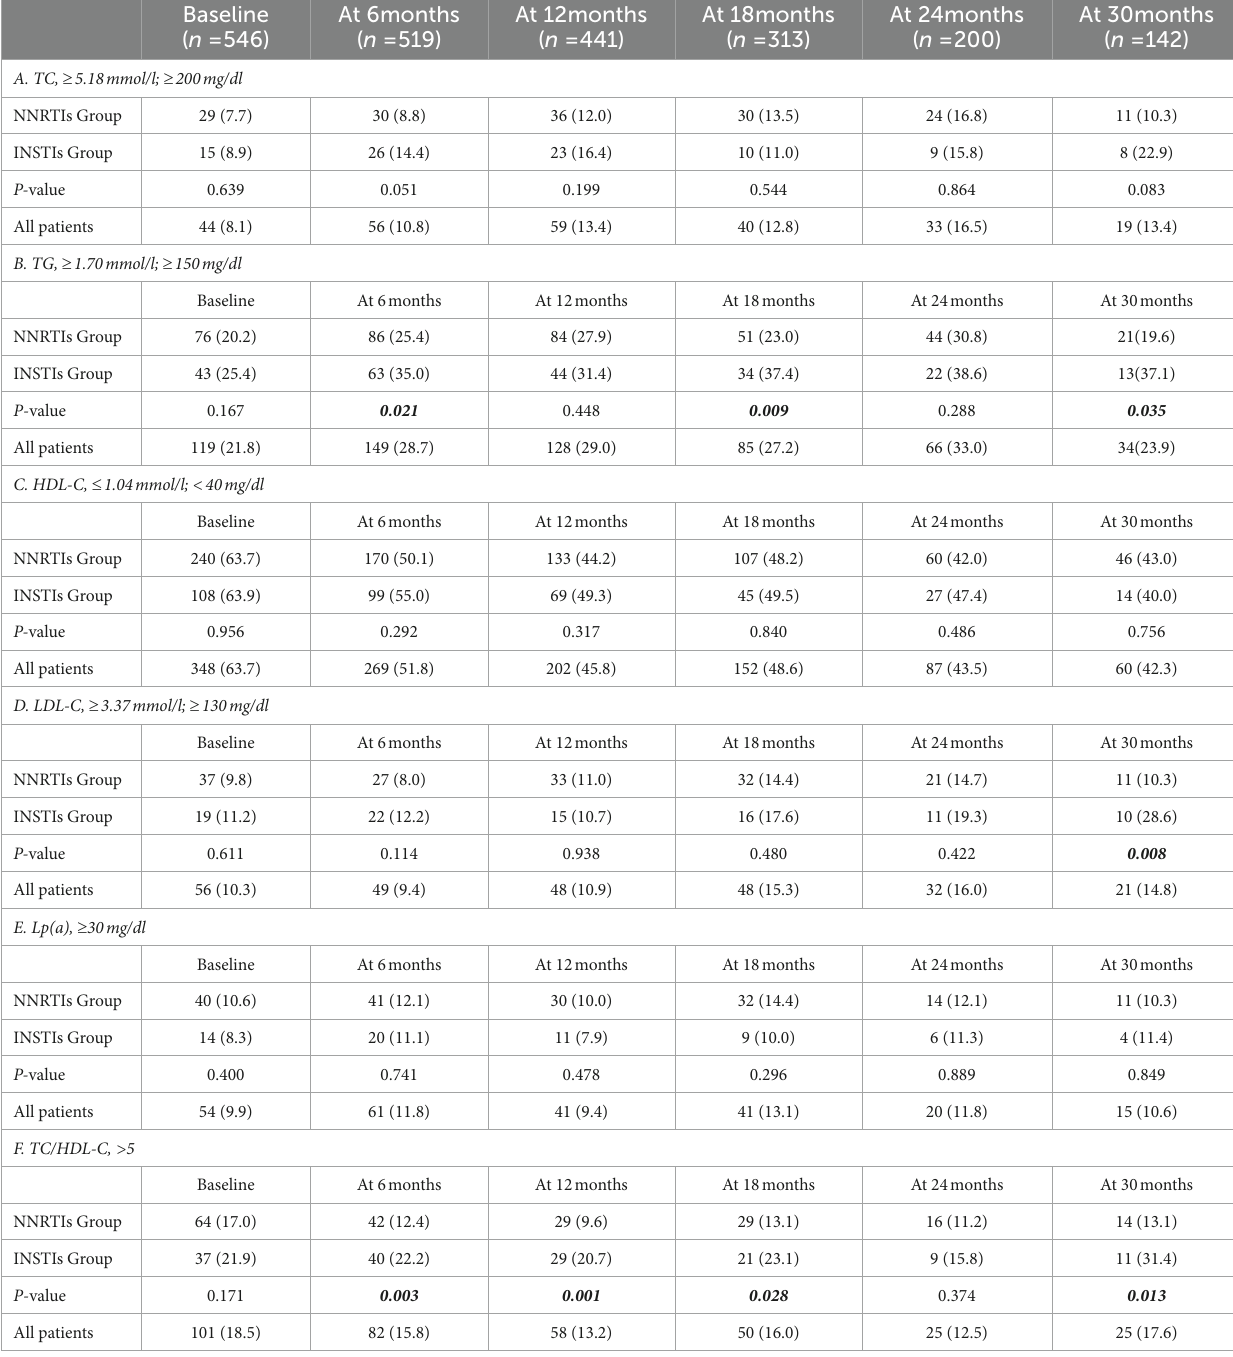
TABLE 3 Prevalence of lipid abnormalities between baseline data with different follow-up periods.